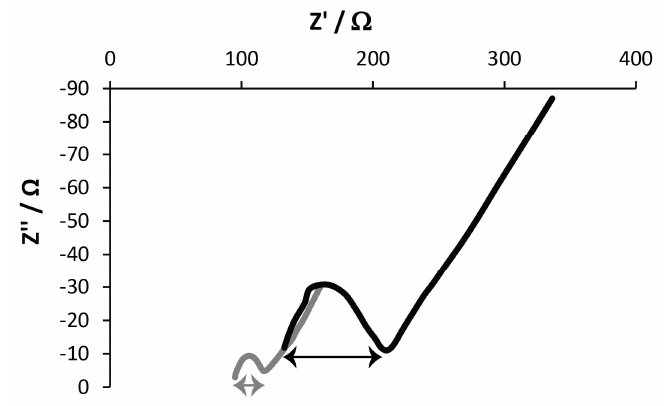
Figure 8. Nyquist plots derived from electrochemical impedance spectroscopy (EIS) data of the films in PBS (pH = 7.4). (Black line) DMP-doped PPY film. (Gray line) MER-doped PPY film.